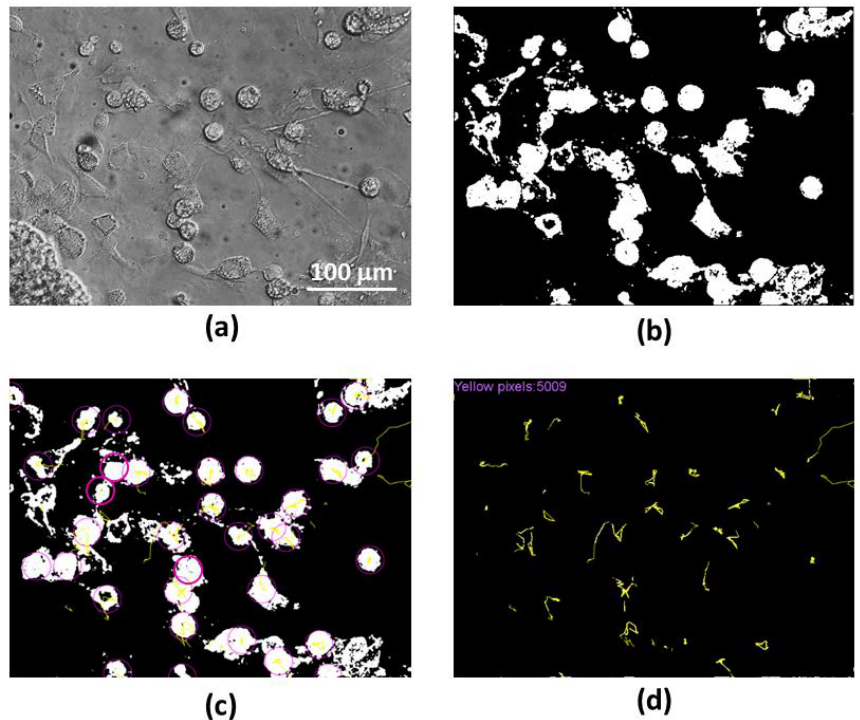
Figure 1. Steps of microglial motility evaluation from time-lapse stacks: ( a ) a representative image of a stack before the assessment; ( b ) the image after conversion to a binary image; ( c ) image was obtained after tracking the selected cells (purple circles) in the stack by the TrackMate; ( d ) the cell tracks and the total number of pixels from all the tracks calculated by the script (in the left upper corner). The scale bar is the same for all images ( a – d ).